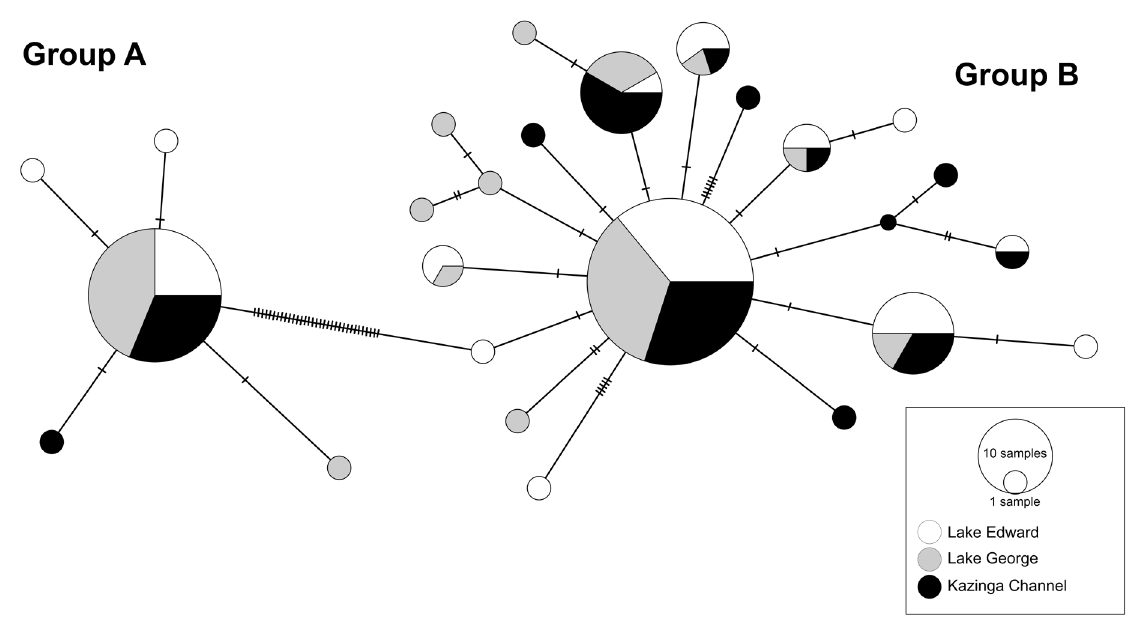
Fig. 1. Haplotype network of 651-bp-long COI sequences (n = 137) of the specimens of Enteromius Cope, 1867 with a smooth, flexible last unbranched dorsal fin ray from the Lake Edward system. Each circle represents a haplotype, with the size of the circles indicating the number of individuals with this haplotype and the colour indicating the different parts of the basin. Each bar represents a mutation between two